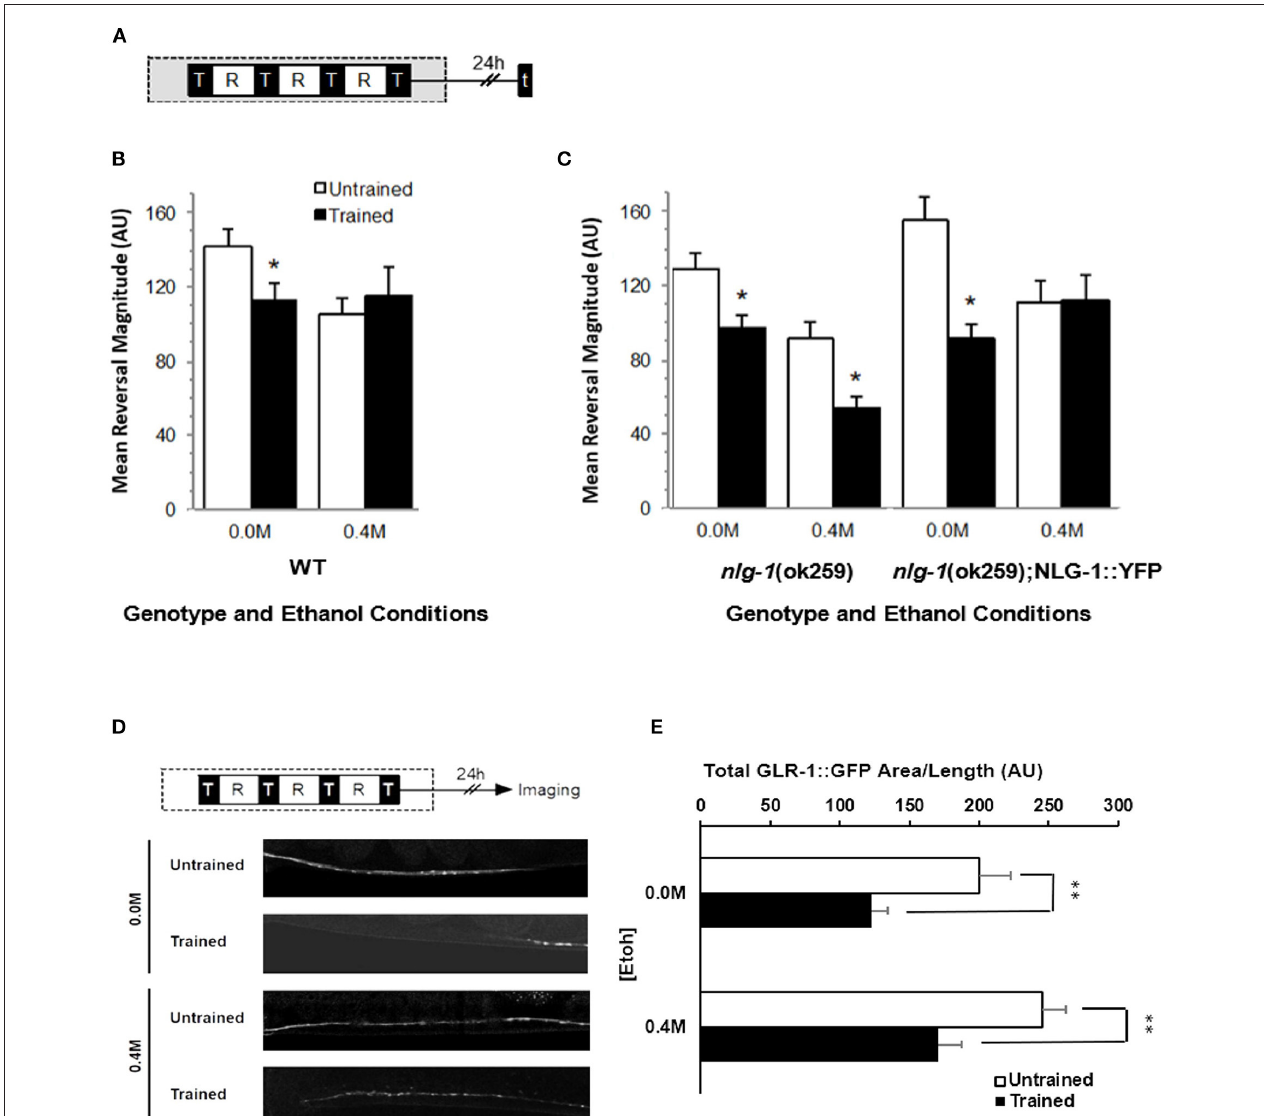
FIGURE 4 | Effects of ethanol exposure during training on long-term memory in nlg-1 mutant worms. (A) Long-term habituation memory training protocol with four training blocks (black squares marked by “T”) separated by 1-h rest period (white squares marked by “R”). 5 test-tap trial indicated by black square marked with “t” or GFP “imaging” was performed 24h after training. Gray shaded area indicates period of ethanol exposure. (B) Mean reversal response magnitude ( ± SEM) to 5 test taps for trained groups (black bars) compared to untrained groups (white bars) for wild-type worms either on (0.4M) or off (0.0M) ethanol. (C) Mean reversal response magnitude ( ± SEM) across 5 taps of nlg-1 mutants or nlg-1 mutant worms expressing an NLG-1 rescue transgene. (D) Examples of confocal images of GLR-1::GFP punctal expression captured from nlg-1 background worms exposed to 0.4M ethanol, comparing expression levels between trained and untrained. (E) GLR-1::GFP punctal expression measured as Mean Total GFP expressing area/worm ( ± SEM) with measures normalized by distance measured along the ventral nerve cord. Measures captured between control (0.0M) and 0.4M ethanol exposure groups with comparisons between trained (black bars) and untrained groups (white bars). * = p < 0.05 ** = p <